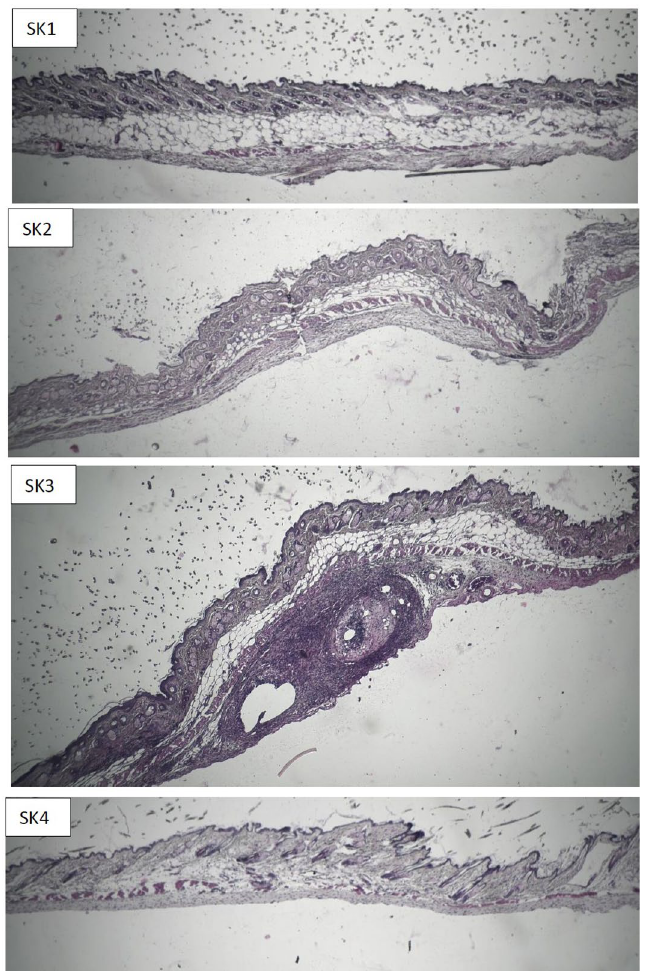
Figure 6. H&E stained pathological samples of Skin in: (SK1) non-EAE group, (SK2) EAE group, (SK3) EAE-GA group, (SK4) EAE-GA/Depot